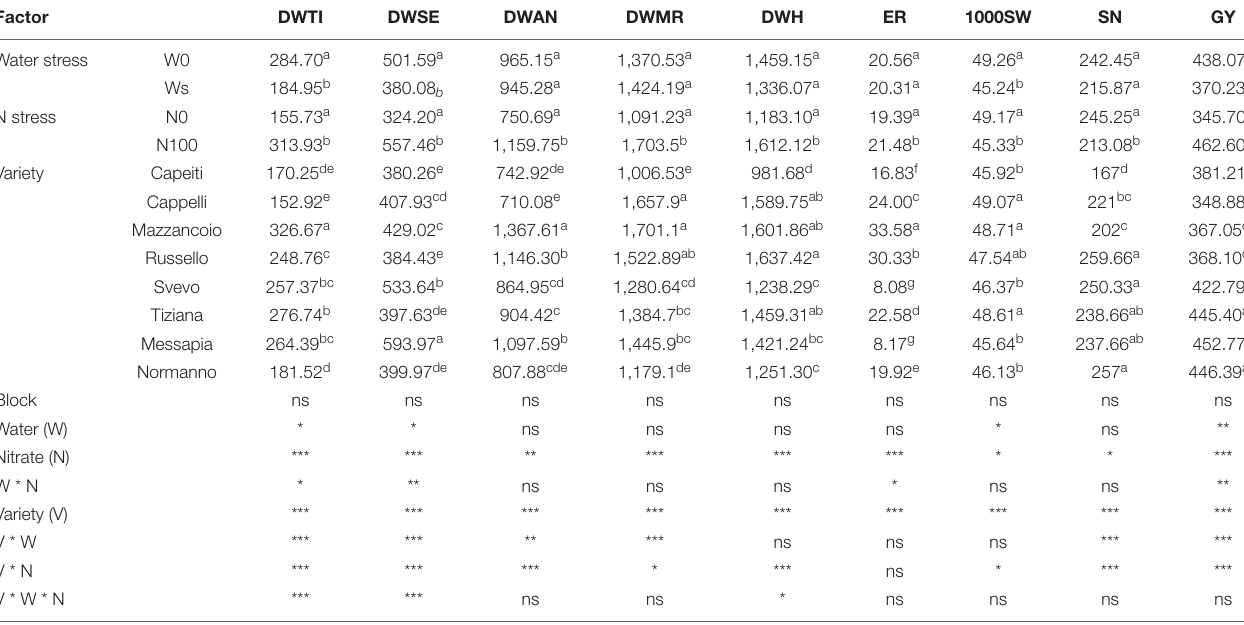
TABLE 1 | Agronomic traits of wheat varieties under two N (0 and 100) and water (20 and 40) regimes in field condition. Factor DWTI DWSE DWAN